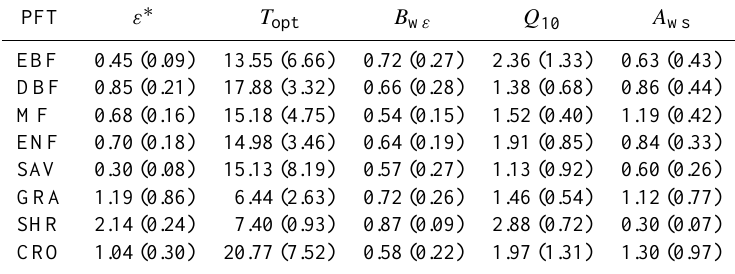
Table 3. Results of the site level parameter optimization organized by plant functional type (PFT): evergreen broadleaf forests (EBF), deciduous broadleaf forests (DBF), mixed forests (MF), evergreen needleleaf forests (ENF), savannah type ecosystems (SAV), grasslands (GRA), shrublands (SHR) and croplands (CRO). The optimized parameters are: maximum light use efficiency ( ε ∗ , [gCMJ − 1 APAR]), optimum temperature for photosynthesis ( T opt , [ ◦ C]), the sensitivity of light use efficiency to water stress ( B w ε , [unitless]) and the effect of temperature ( Q 10 , [unitless]) and water availability ( A ws , [unitless]) on heterotrophic respiration (for a detailed description see Carvalhais et al., 2008). Values in parenthesis report the standard deviation around the mean parameters calculated from the optimized parameters and standard error for all the sites of each PFT.